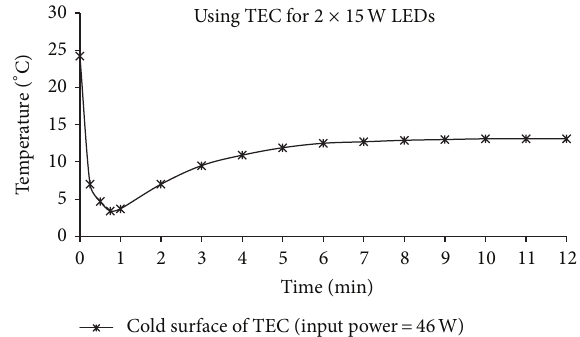
Figure 8: The change of the cold surface temperature of the TEC in the 2 × 15 W LEDs system.